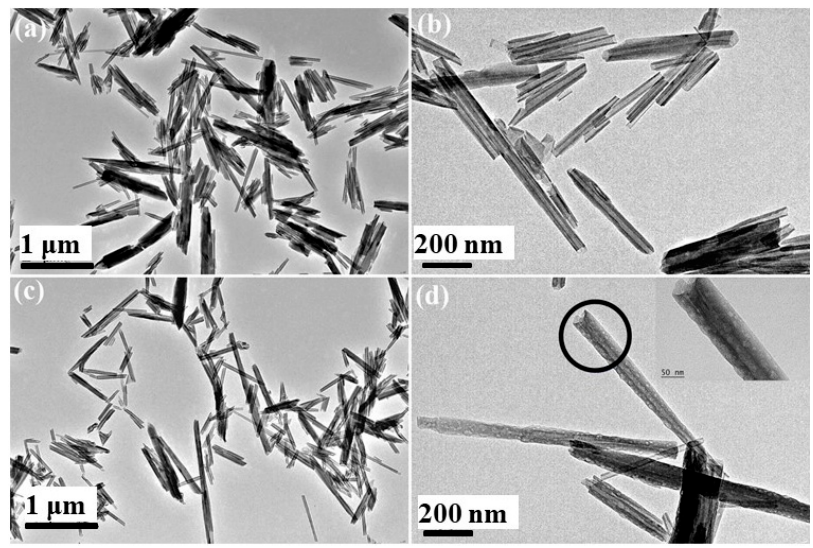
Figure 6. Transmission electron microscopy (TEM) images of HNTs before ( a , b ) and after ( c , d ) CIP adsorption.